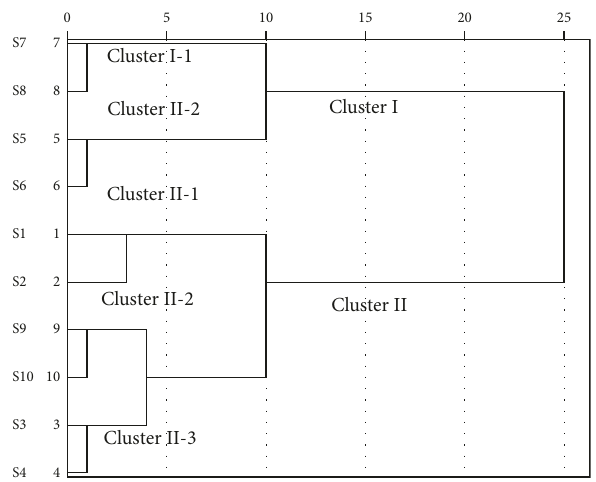
Figure 4: Clustering analysis of ten batches of Berberidis Cortex from different origins.